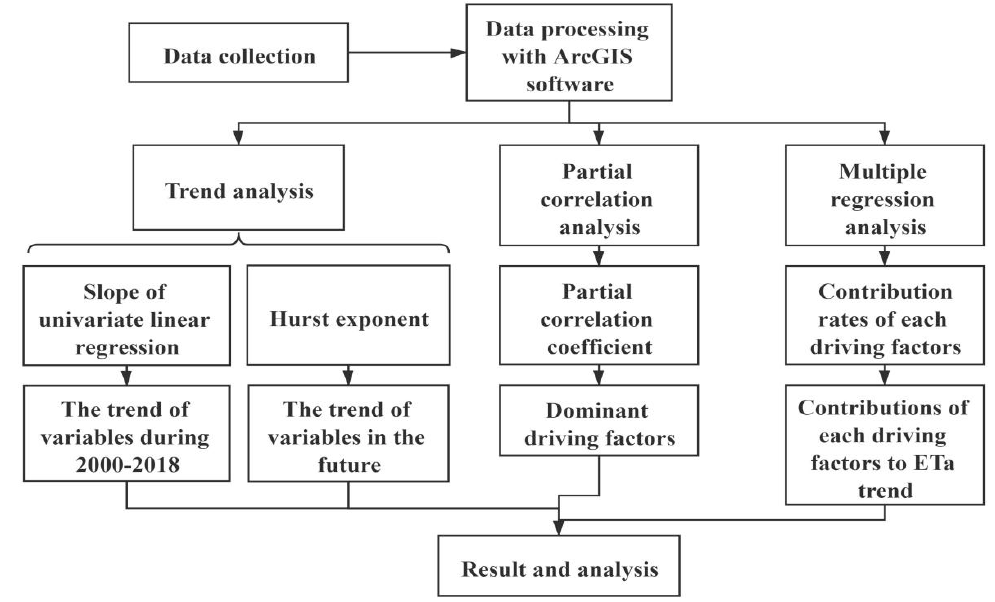
Figure 2. Technology